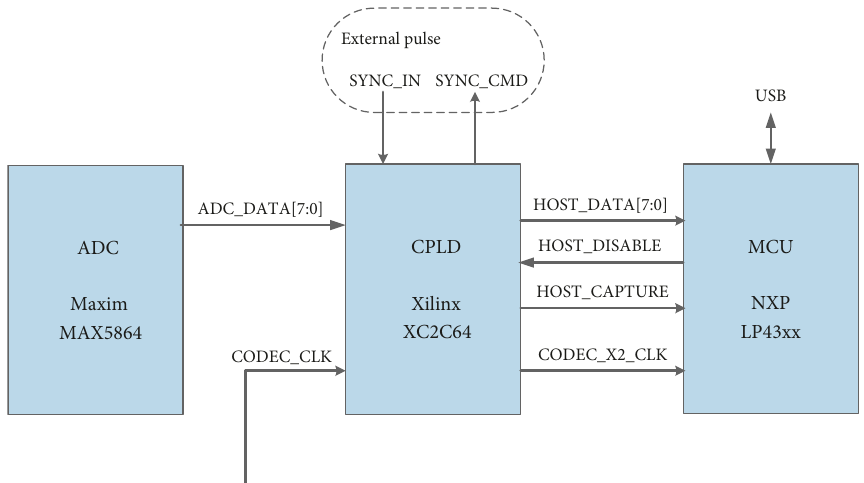
Figure 4: Hardware connection